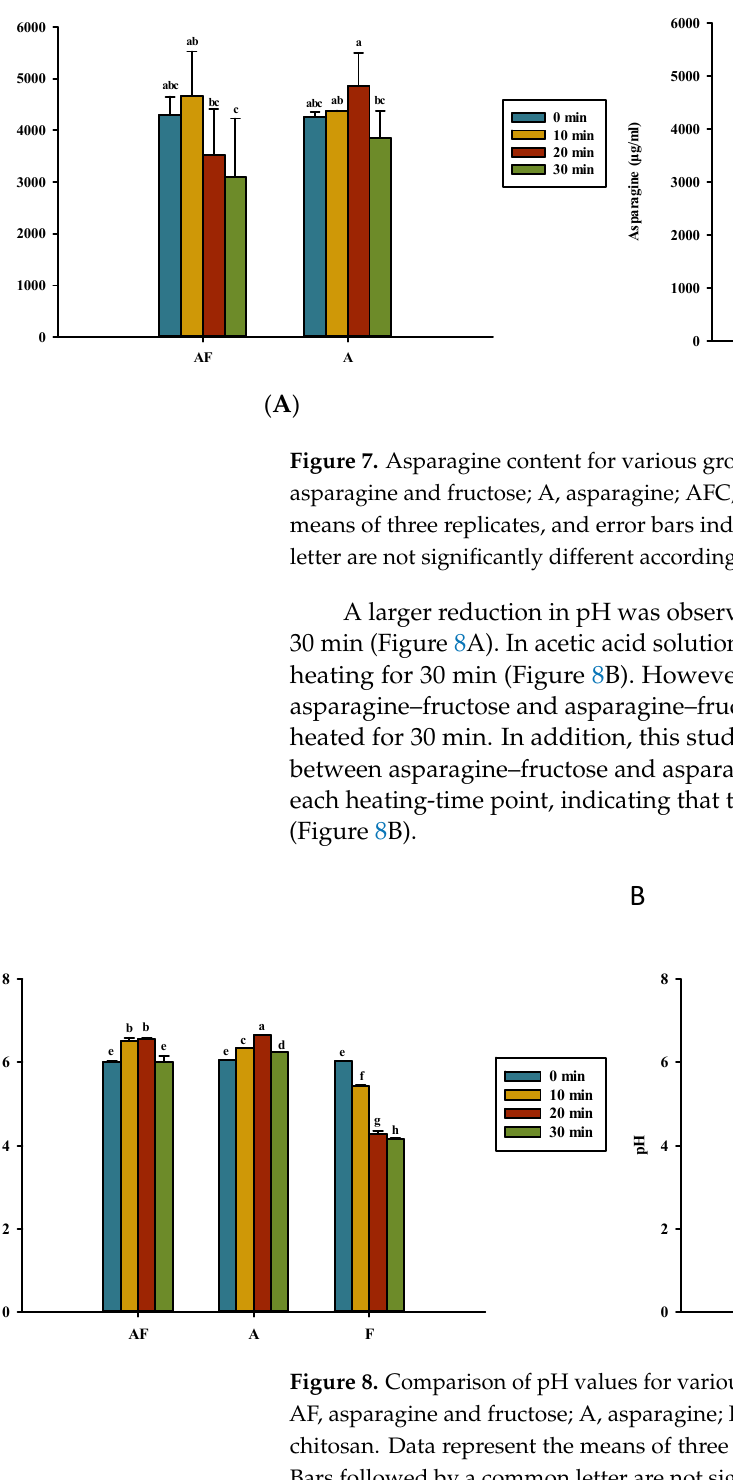
b a d d Figure 6. Reducing sugar concentration for various groups upon heating in ( A ) water and ( B ) acetic acid. AF, asparagine and fructose; A, asparagine; F, fructose; C, chitosan; AFC, asparagine, fructose and chitosan. Data represent the means of three replicates, and error bars indicate standard devia- tion. Bars followed by a common letter are not significantly different according to the Dunn’s test at the 5% level of significance (ND, not detected). Figure 7 presents the heating effect on the asparagine content in solutions tested in